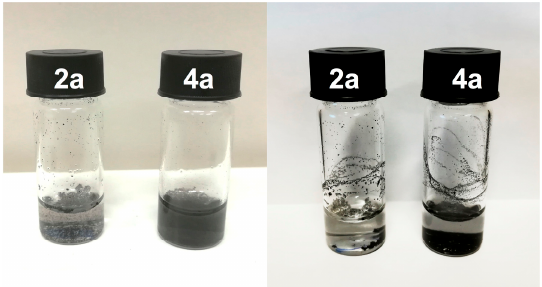
Figure 7. Suspensions of 2a and 4a in H 2 O (1 mg · mL − 1 ) just after sonication (left panel) and 10 min later (right panel).